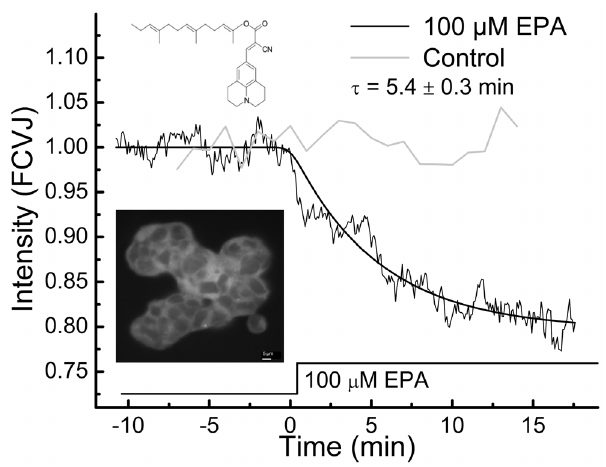
Figure 6. Membrane viscosity changes with fatty acids. Measured signal intensity of HEK293 cells stained with FCVJ as a response to 100 m M EPA or control treatment in chambered cover glass at 37 u C. Data represents the mean of at least 12 independent experiments.